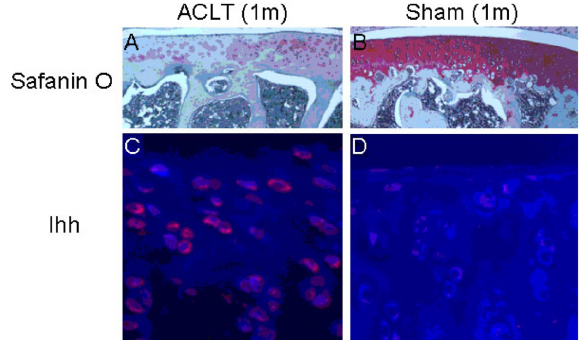
Figure 6. Elevated Ihh found in surgery-induced OA models. Elevated Ihh was found in a rat OA model induced by anterior cruciate ligament transection (ACLT) one month after surgery. In this model, there was decreased proteoglycan (PG) staining determined by Safranin O ( A ) compared with sham control ( B ) one month after surgery; immunohistochemistry (IHC) staining revealed increased Ihh in the surgically-induced OA cartilage ( C ) compared to sham ( D ). The expression of Ihh observed in the model is similar to that seen in human OA cartilage. 1m: 1 month after